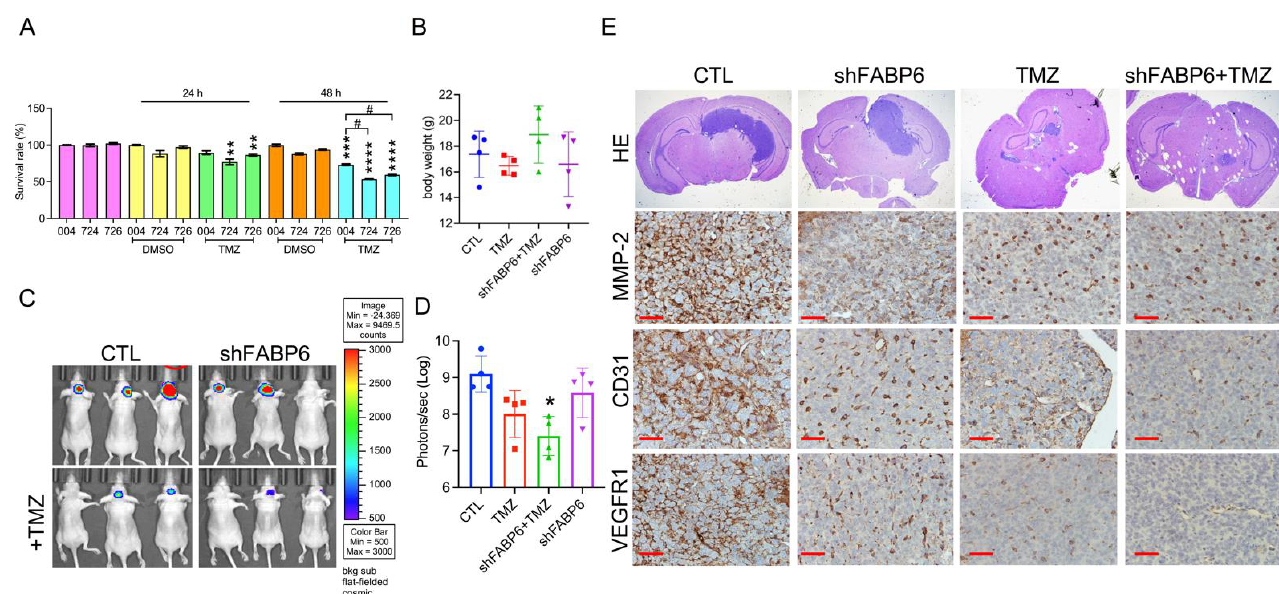
Figure 7. The effect of FABP6 knockdown on the tumor progression of LN229 cells in an orthotropic xenograft mouse model: ( A ) the survival rates of the glioma cell line in scrambled cytotoxic T lymphocyte (CTL) and shFABP6 combined with or without 100 μM temozolomide (TMZ) for 24 and 48 h ( n = 6); ( B ) the body weights of animals are shown; ( C ) the effects of different groups on the size and growth of tumors were observed using bioluminescent imaging with an in vivo imaging system (IVIS); ( D ) quantification of the bioluminescence data in different groups; ( E ) HE staining of the xenograft orthotropic brain tissues. * p < 0.05; ** p < 0.01; *** p < 0.001; **** p < 0.0001 compared with the DMSO control group. # p < 0.05 compared with shScramble control + TMZ group. Scale bar = 50 m.